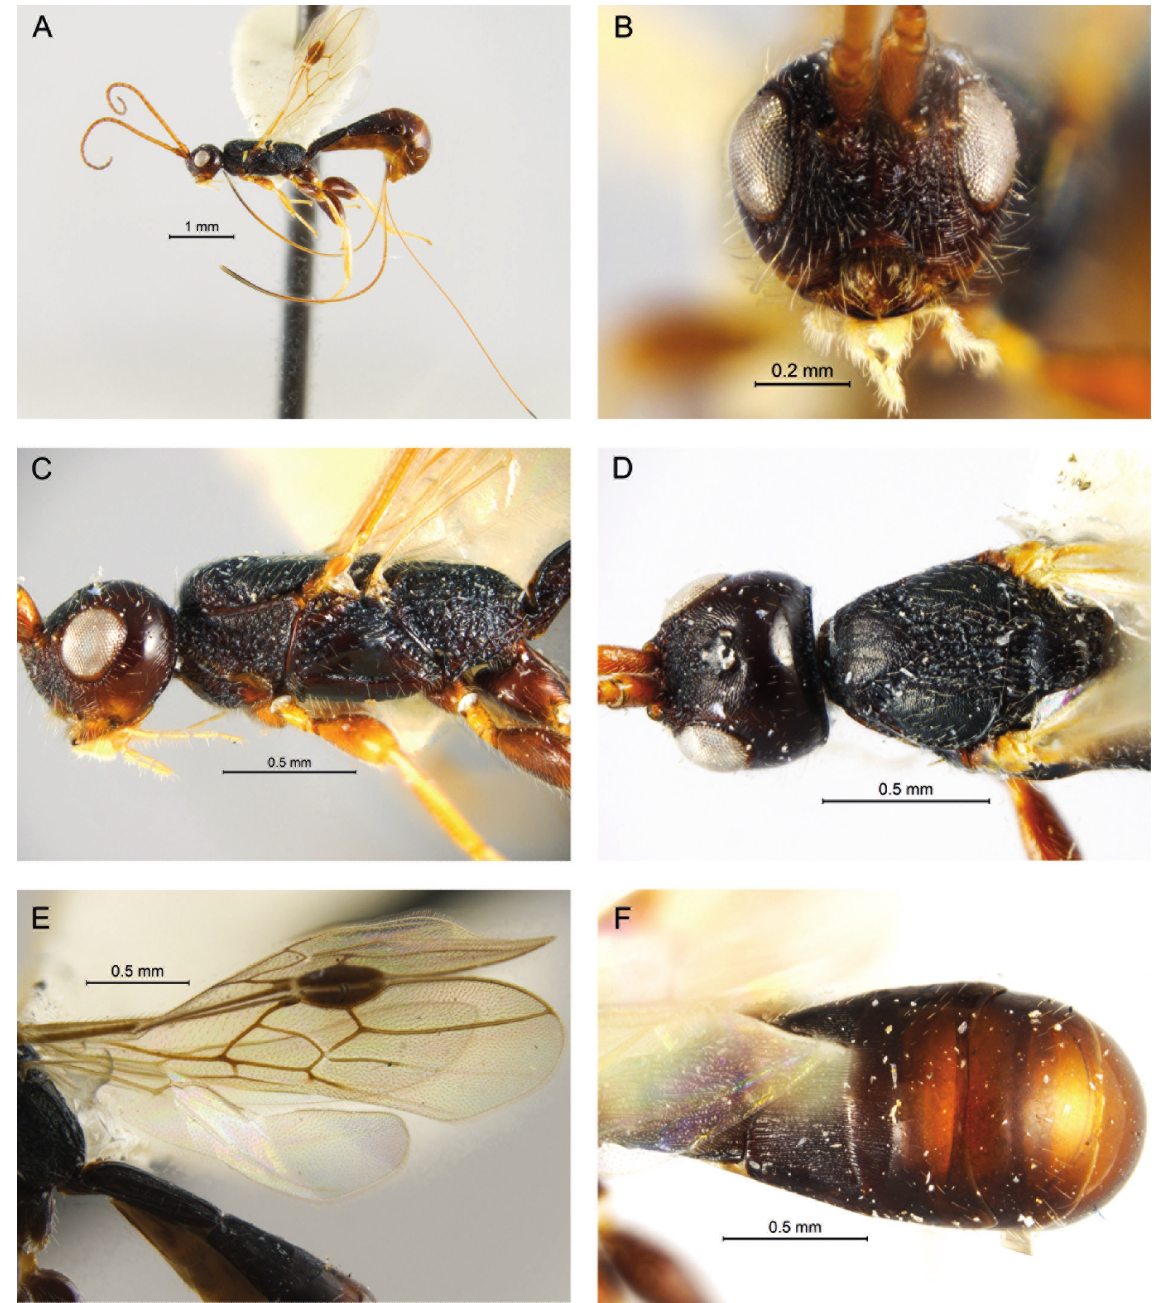
Fig. 6. Hecabolus mexicanus Zaldívar-Riverón & Belokobylskij, 2009, ♀ (CNIN-IBUNAM). A . Habitus, lateral view. B . Head, frontal view. C . Mesosoma, lateral view. D . Mesosoma, dorsal view. E . Fore and hind wings. F . Metasoma, dorsal